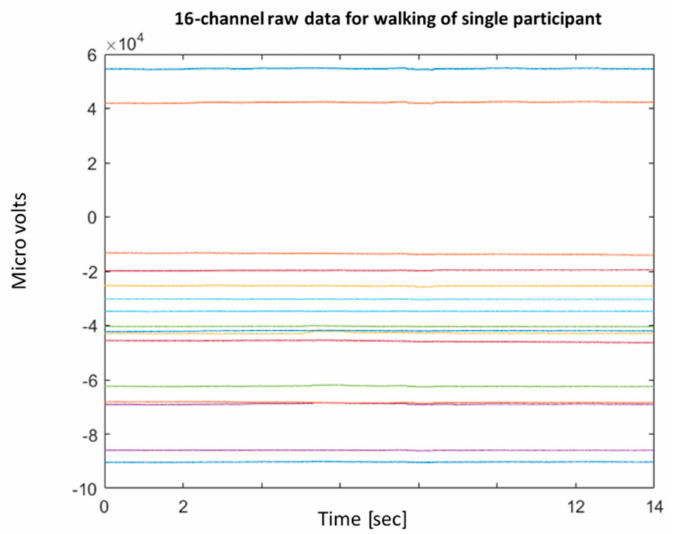
Figure 13. Raw EEG data of the 16 channels over 14 s during walking of a single